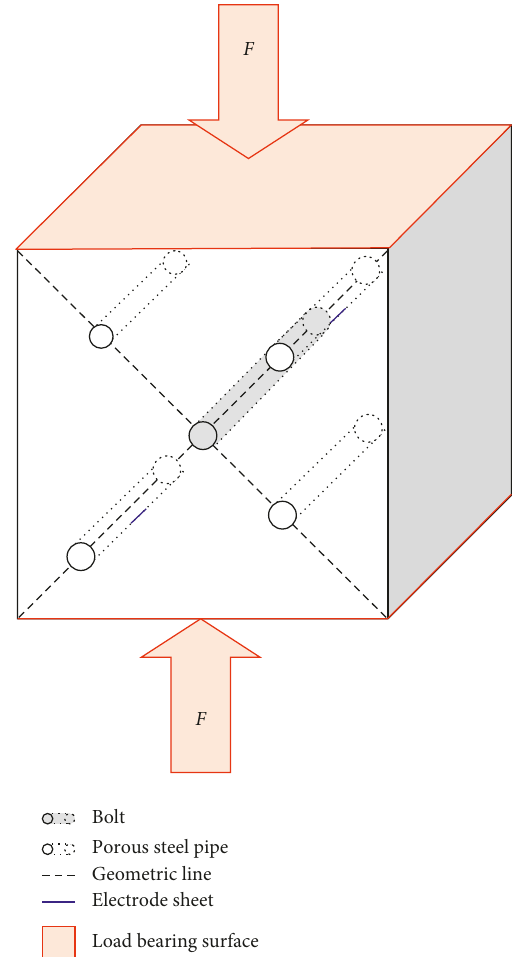
Figure 1: Specimen